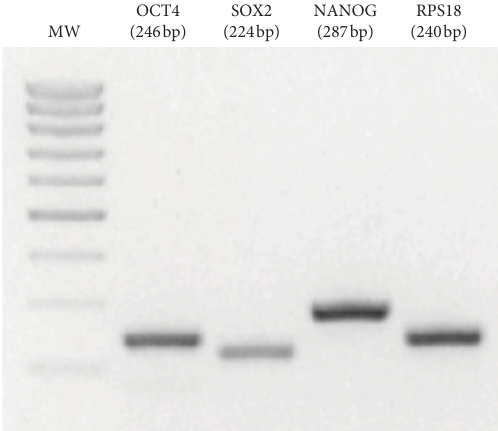
Figure 3: Ethidium bromide-stained agarose gel electrophoresis of RT/PCR products showing clearly defined bands corresponding to NANOG, OCT4, and SOX 2 amplicons of the expected size (RPS18: ribosomal protein